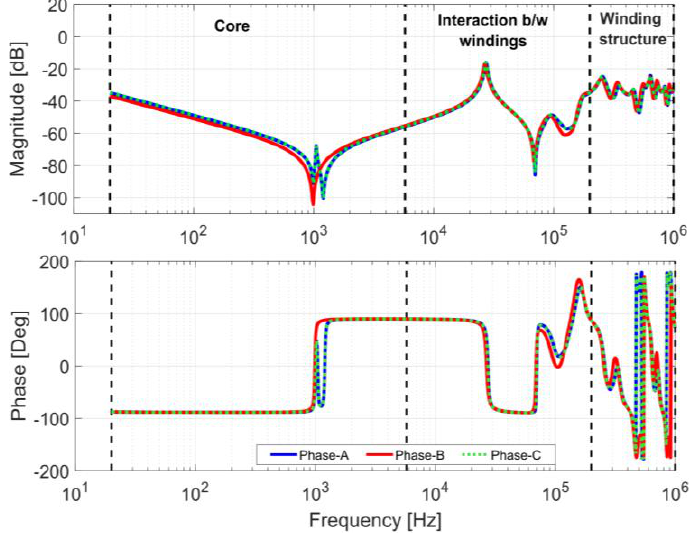
Figure 7. HV-OC frequency response of HF model of three-phase transformer (vector group: YNyn0).